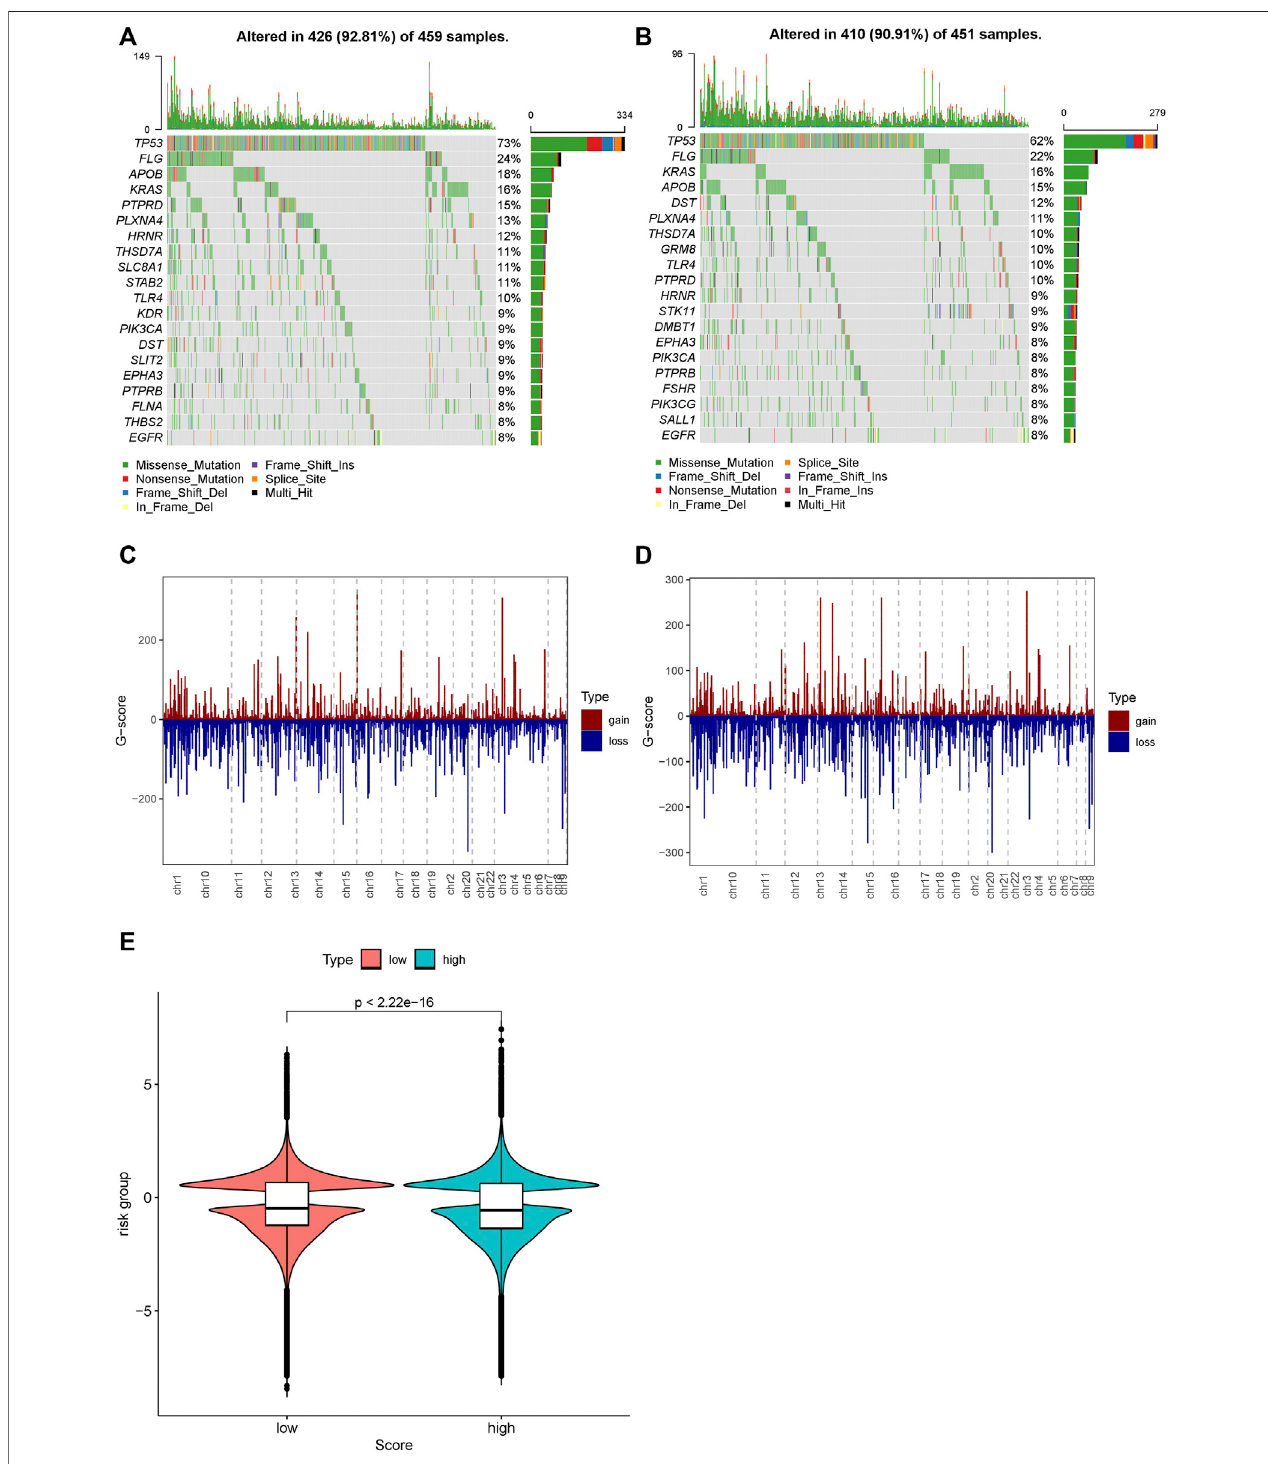
FIGURE9| DistributionofmutationsandCNVsinthehigh-andlow-riskgroups. (A) Mutationsinthehigh-riskgroup. (B) Mutationsinthelow-riskgroup. (C) CNVs in the low-risk group. (D) CNVs in the high-risk group. (E) Distribution of the G-score and the p -value of the Wilcoxon test in the high- and low-risk groups.